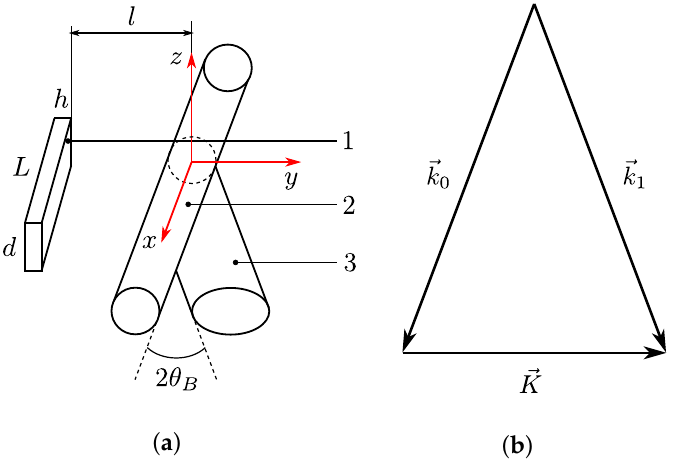
Figure 1. ( a ) Schematic of AO Bragg diffraction: 1—sound transducer; 2—transmitted radiation; 3—diffracted radiation; ( b ) wave vector diagram of AO